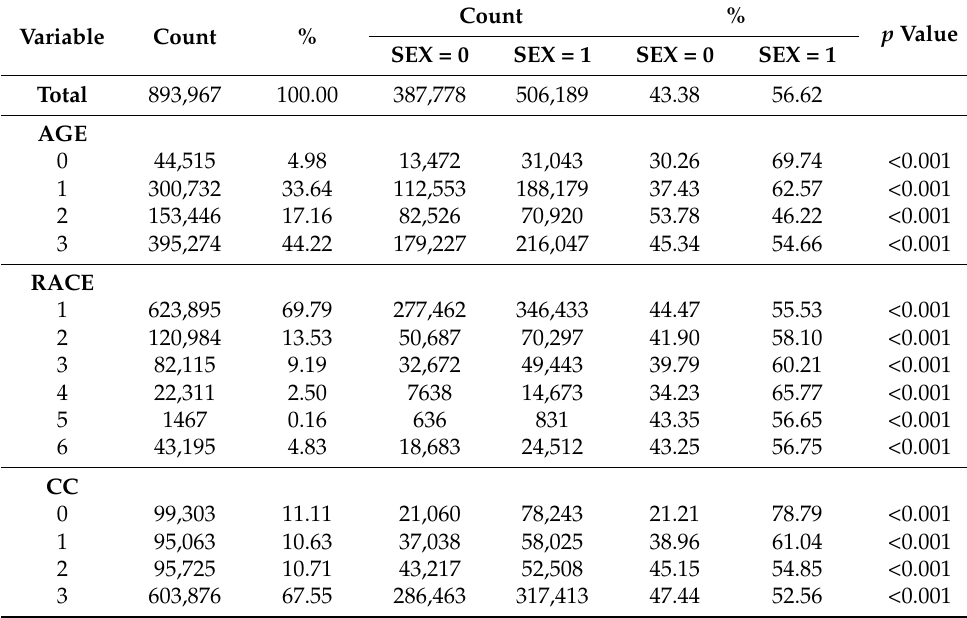
Table 2. Characteristics of patients among SEX. Chi-square test is used to calculate p values for differences across male (SEX = 0) and female (SEX =